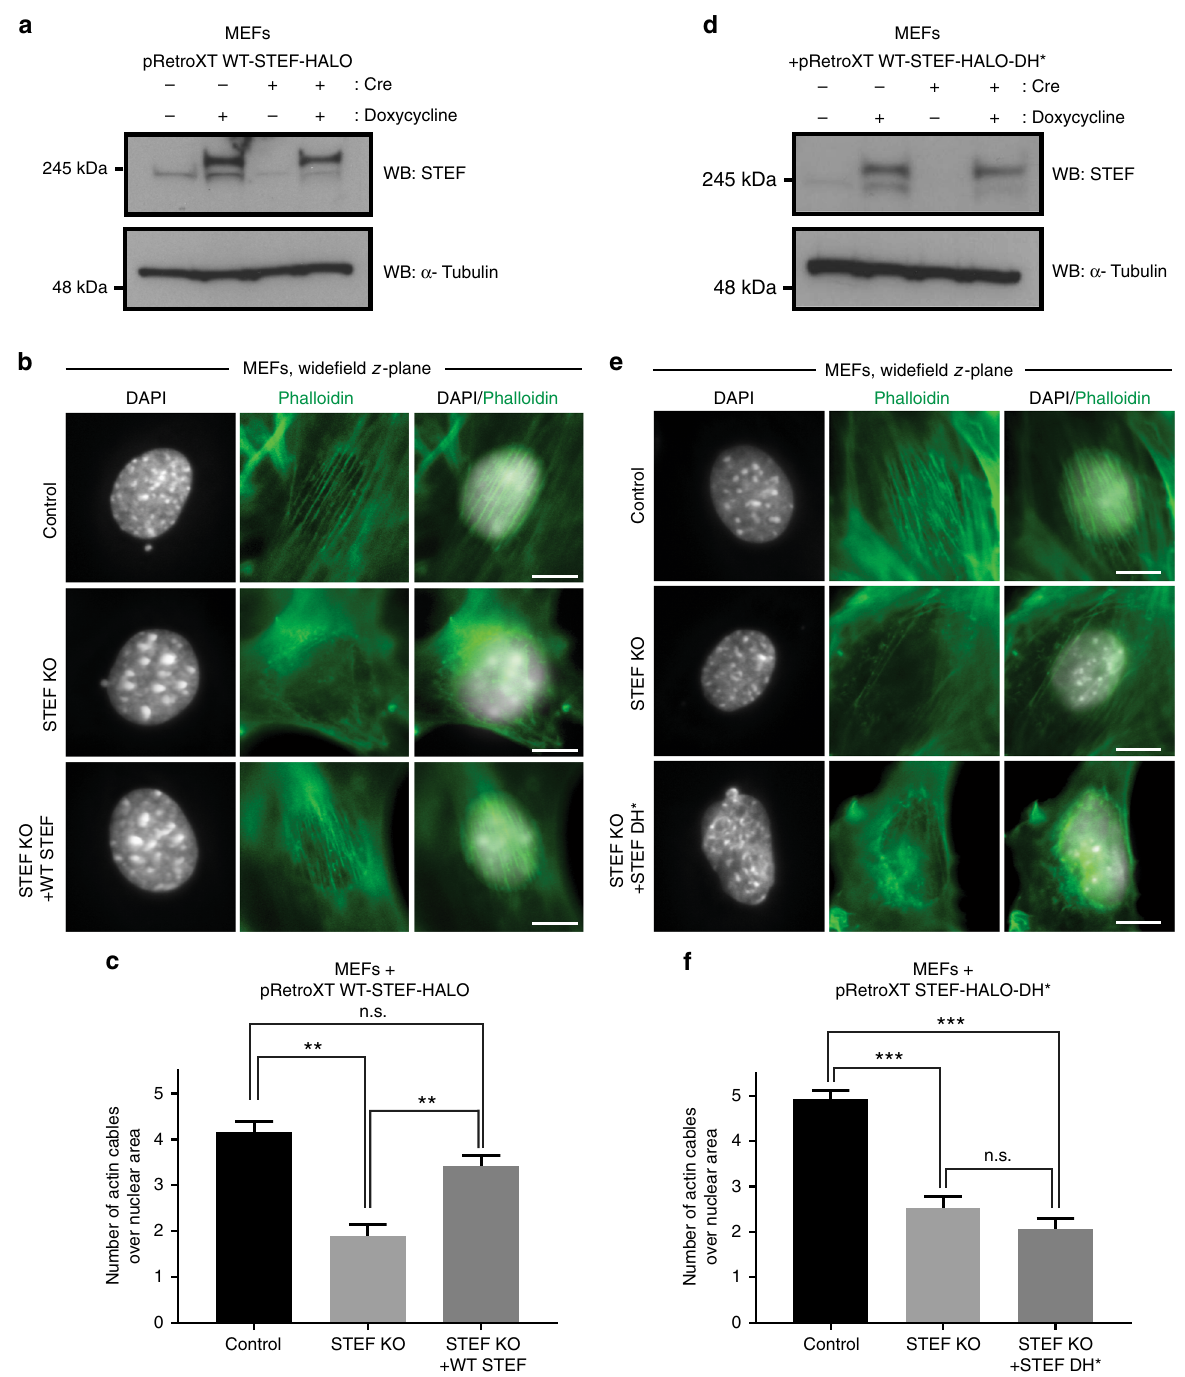
Fig. 3 STEF depletion disrupts the apical perinuclear actin cables. a , d Conditional STEF KO MEFs with inducible expression of either pRETROXT-Pur-STEF- HALO ( a ) or pRETROXT-Pur-STEF-DH*-HALO ( d ) were generated and pre-incubated in the presence or absence of doxycycline for 24 h, prior to infection with either adenoviral-Cre ( + Cre) to deplete STEF or an empty adenoviral control (-Cre). Lysates were harvested after 72 h and STEF expression was determined by western blotting. α -Tubulin was used as a loading control. b , e Representative wide fi eld immuno fl uorescence images of sparsely plated MEFs treated as in a and d , stained for DNA (DAPI) and F-actin (Phalloidin). Scale bar = 10 µ m. c , f Quanti fi cation of apical actin cable number over nuclear area from cells as in b and e . Values represent the mean of three independent experiments ± S.E.M ( >25 cells per condition, per replicate). Statistical signi fi cance was veri fi ed using a one-way ANOVA, using Tukey ’ s multiple comparison test to compare the means of each sample. ** p < 0.01, *** p < 0.001, n.s. = not signi fi